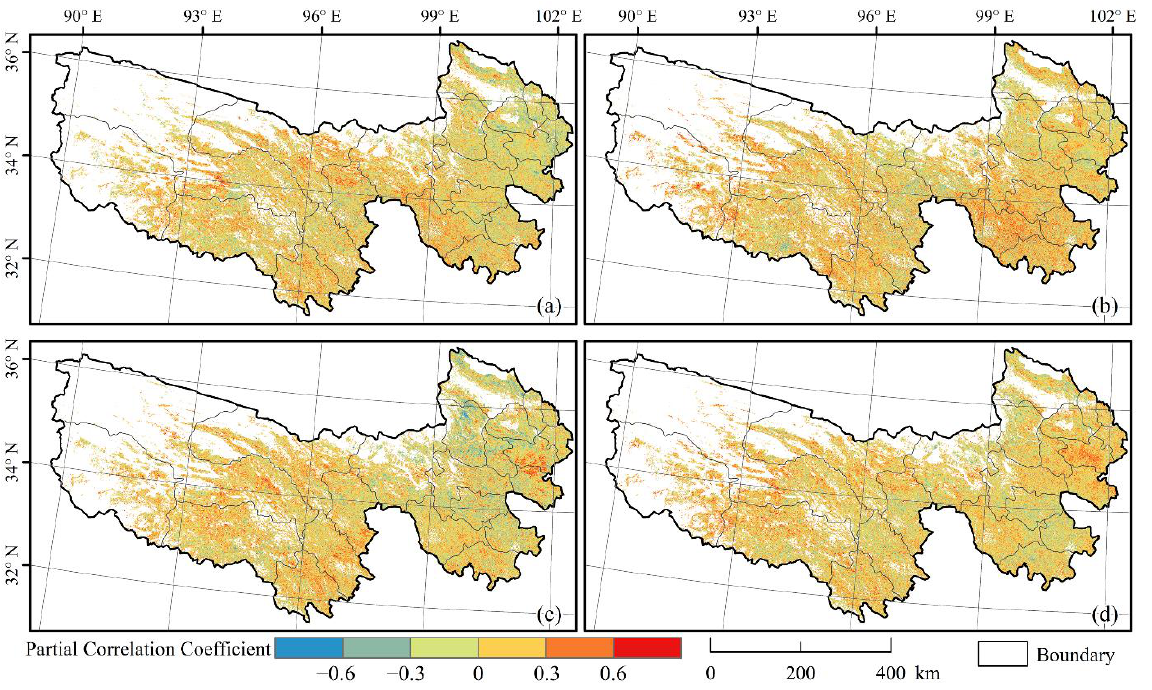
Figure 14. Spatial distribution of the partial correlation coefficients between the EOS of the vegetation and air temperature in August ( a ), September ( b ), October ( c ) and August – October ( d ) in the Three-River headwaters region.